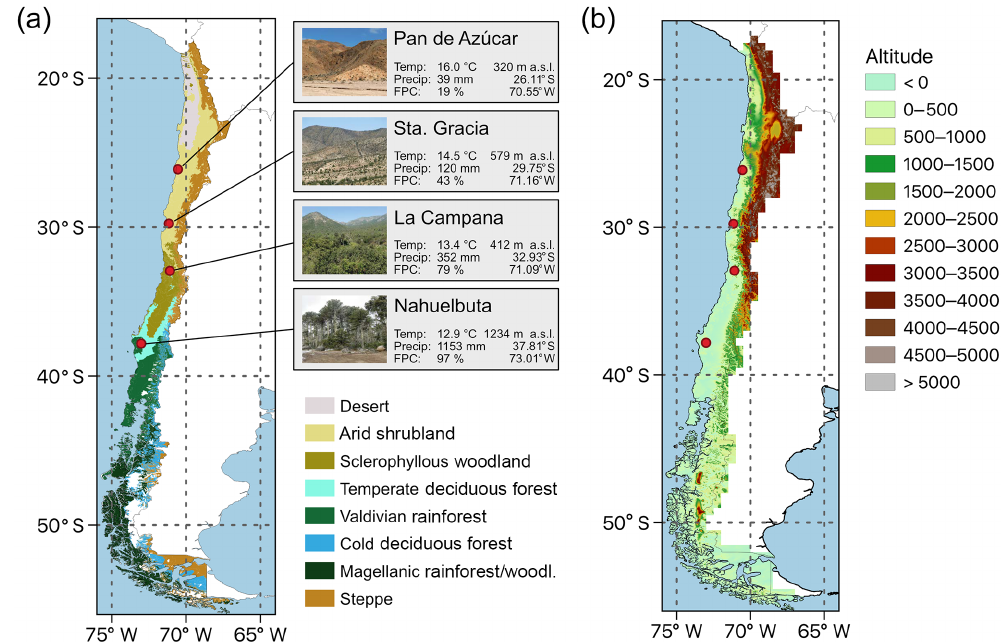
Figure 1. (a) Distribution of major vegetation zones in Chile the and location of the four EarthShape SPP focus sites: Pan de Azúcar, Sta. Gracia, La Campana, and Nahuelbuta (“Temp” represents average annual temperature, “Precip” represents average annual precipitation – data: ERA-Interim 1960–1989, and “FPC” represents foliage projected cover (MODIS VCF v6, total vegetation cover, 2001–2016 average, Dimiceli et al., 2015). Vegetation zones are based on Luebert and Pliscoff (2017). (b) Elevation of the model